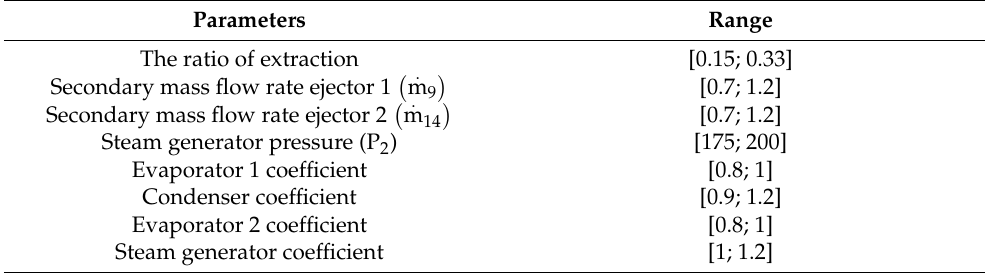
Table 7. The decision variables’ range of the optimization of the system. Parameters Range The ratio of extraction [0.15; 0.33]